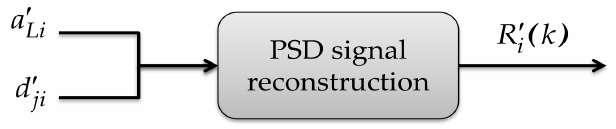
Figure 10. PSD reconstruction after impulsive